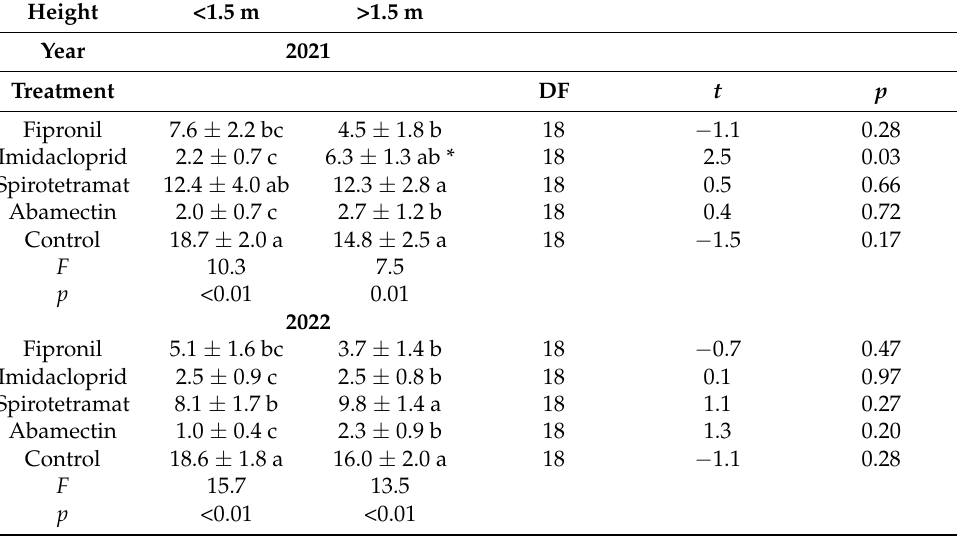
Table 3. Mean number ( ± Standard Errors) of Xylotrechus chinensis exit holes from the trees treated with abamectin, fipronil, imidacloprid, and spirotetramat or untreated trees (controls), below or above the 1.5 m from the ground, during 2021 and 2022. Within each row, significant differences are indicated by asterisks (two-tailed t -test at p = 0.05). Within column, means followed by the same lowercase letter do not differ significantly (Tukey–Kramer HSD test at p = 0.05). No asterisks indicate no significant